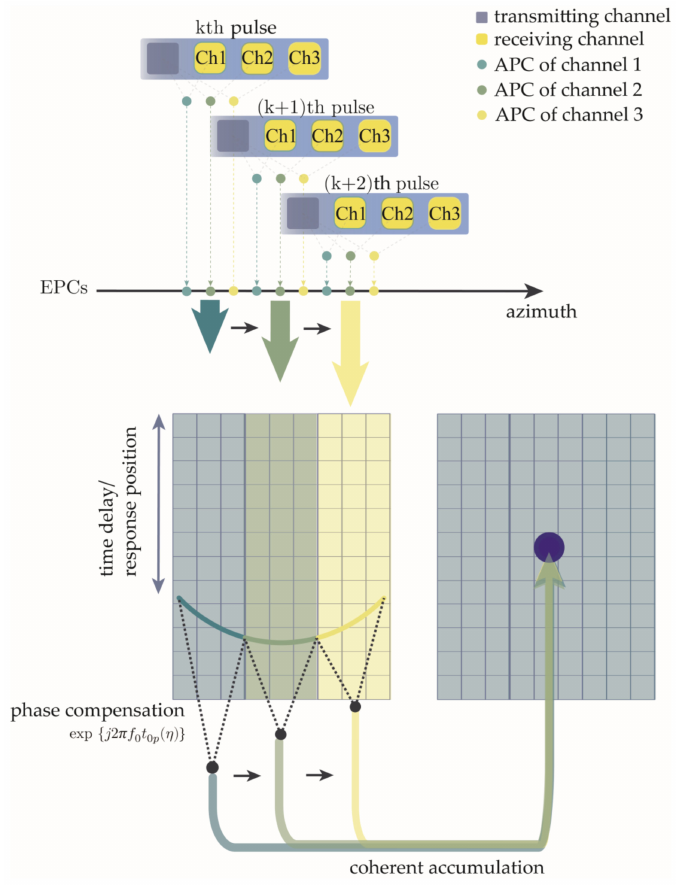
Figure 9. Streaming BP processing